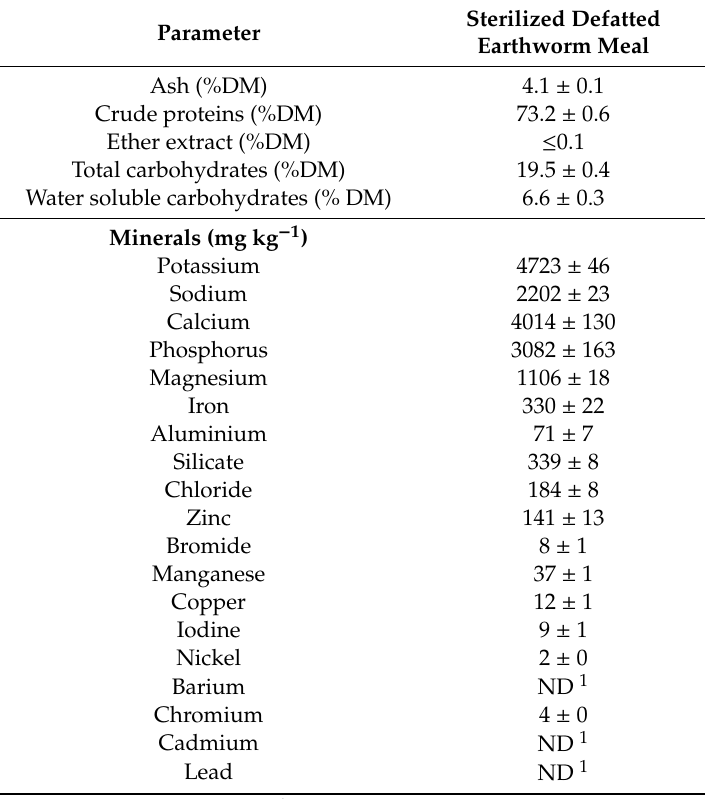
Table 3. Quality parameters of the sterilized defatted earthworm